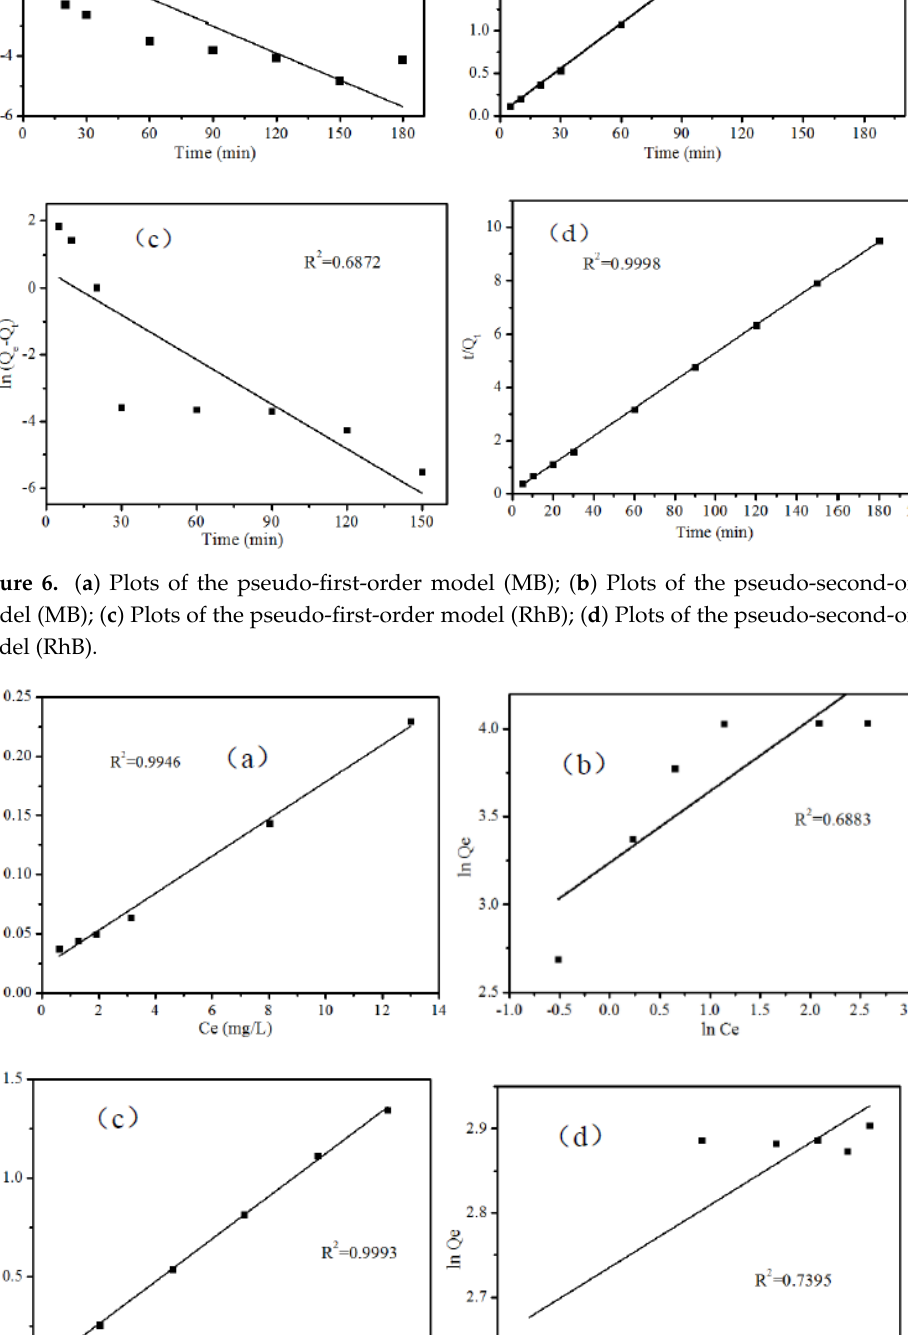
Figure 6. ( a ) Plots of the pseudo-first-order model (MB); ( b ) Plots of the pseudo-second-order model (MB); ( c ) Plots of the pseudo-first-order model (RhB); ( d ) Plots of the pseudo-second-order model (RhB).